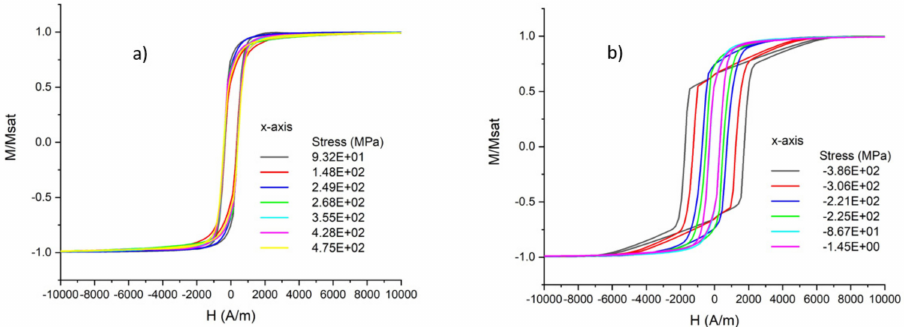
Figure 10. ( a ) Magnetization curves for samples with tensile stress and ( b ) compressive stress measured along the